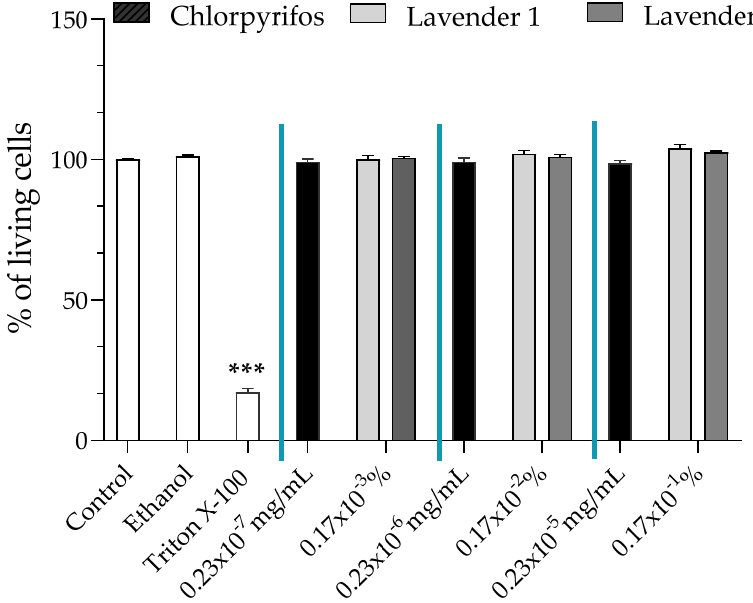
Figure 1. Cell viability was evaluated using the alamar blue assay after incubation of JEG-Tox cells with chlorpyrifos at 0.23 × 10 − 7 mg/mL, 0.23 × 10 − 6 mg/mL and 0.23 × 10 − 5 mg/mL or two lavender essential oils (EOs 1 and 2) at 0.17 × 10 − 3 %, 0.17 × 10 − 2 % and 0.17 × 10 − 1 % for 72 h. Triton ® X-100 at 0.016% was used as a positive control. Significance levels were *** p < 0.001.